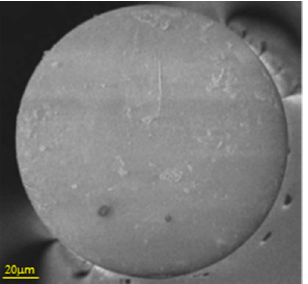
Figure 20. SEM image from a multimode cleaved ended fibre onto which a xerogel has been deposited to measure humidity changes; the uniformity of the resulting coating once the curing process is finished is remarkable. Reprinted from [83] with permission from Elsevier.